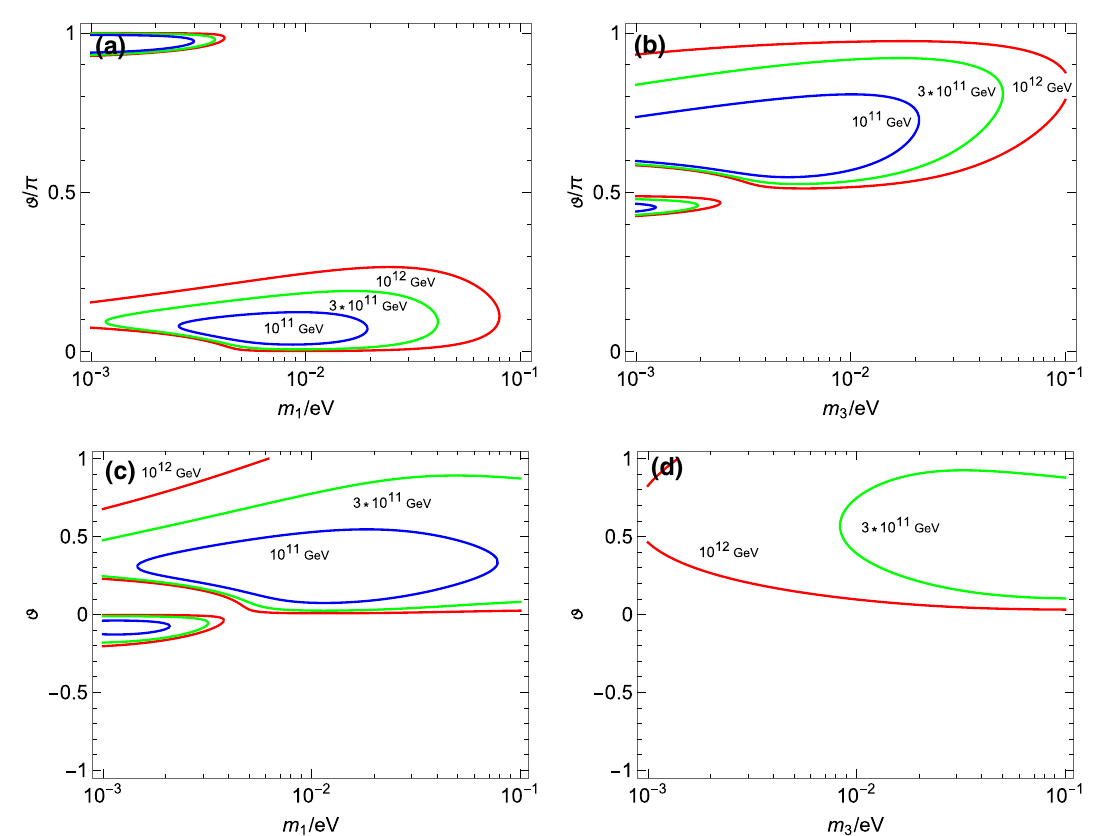
= 1 ( a ); the IO case with 1 = − 1 ( a ); the IO case with η = − 1 1